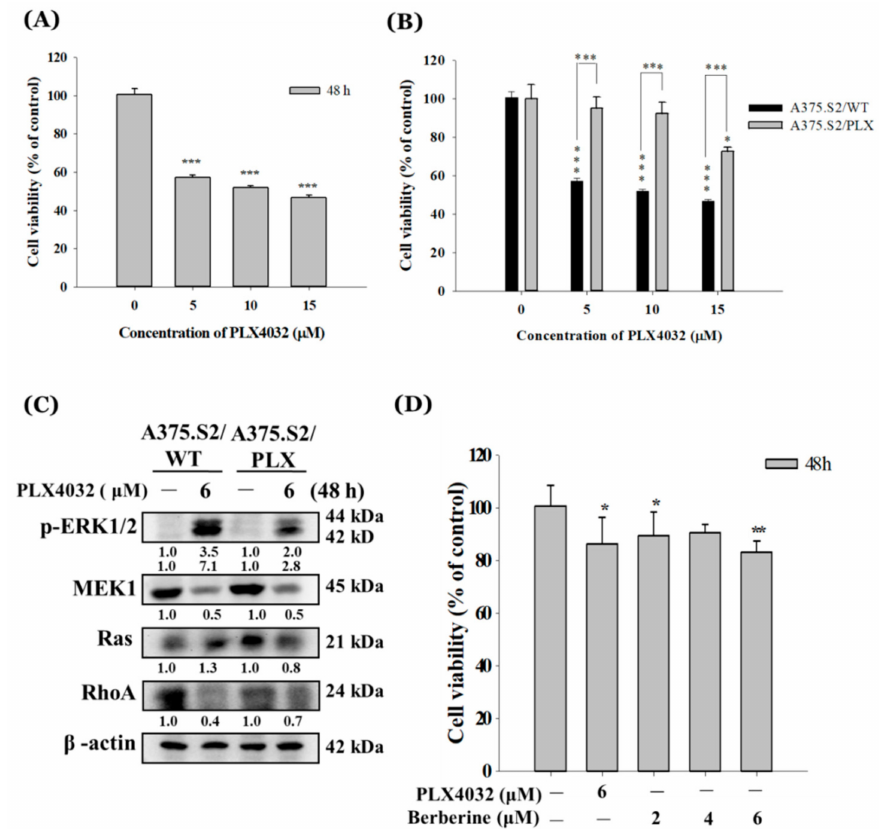
Figure 5. PLX4032 and berberine decreased the viable cell number in A375.S2 cells and PLX4032 resistant A375.S2 cells. The A375.S2 cells were treated with 0, 5, 10, and 15 µ M of PLX4032 and were